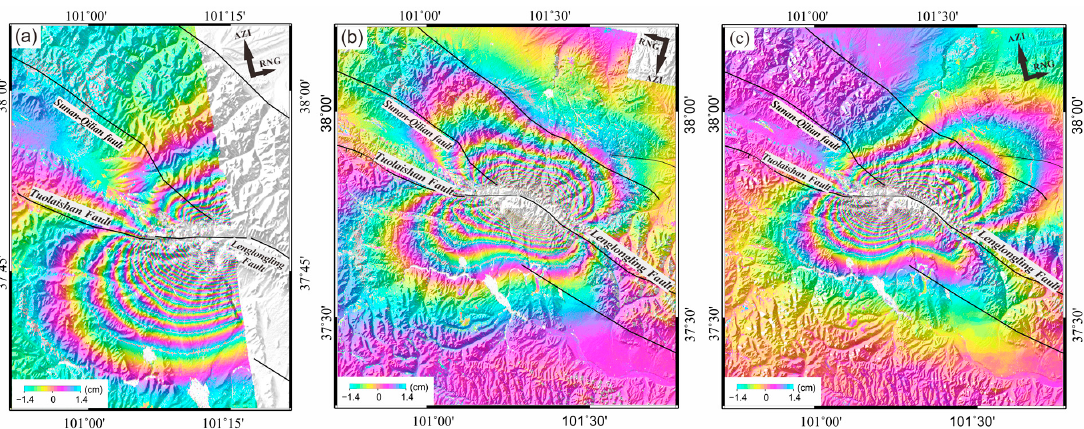
Figure 3. ( a ) Coseismic deformation of the 2022 Menyuan earthquake event derived from Sentinel-1 Ascending Track 26. ( b ) Coseismic deformation fields from Descending Track 33. ( c ) Coseismic deformation fields from Ascending Track 128. The black lines indicate faults distributed near the epicenter.